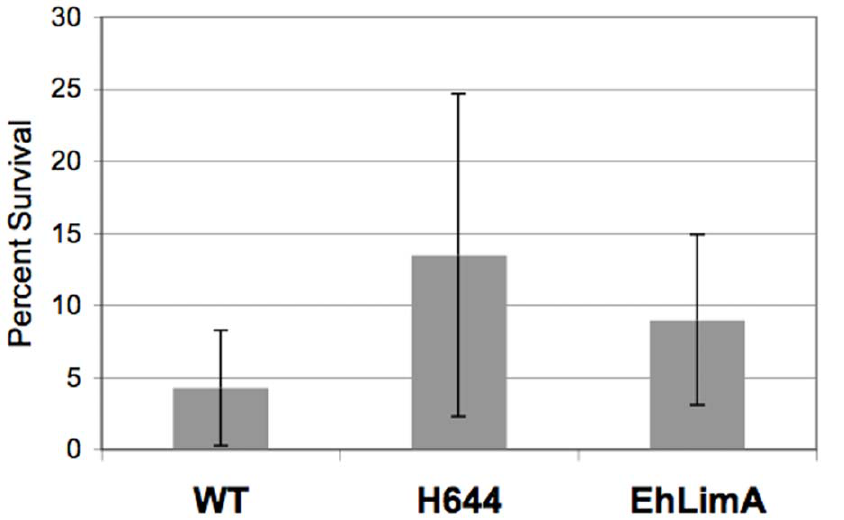
Figure 5. Tubercidin-loaded erythrocytes are less toxic to E.histolytic cells over-expressing H644 or EhLimA. Transgenic trophozoites were exposed to tubercidin-loaded erythrocytes (3 treatments) and viability was assessed 48 hours after treatments. The data are reported as a percent of the starting number of viable amoebae before treatment. The data represent the mean 6 S.D of 3 trials. E. histolytica transgenic cells exposed to tubercidin-charged hRBCs displayed increased survival as compared to untransfected wild-type (WT)